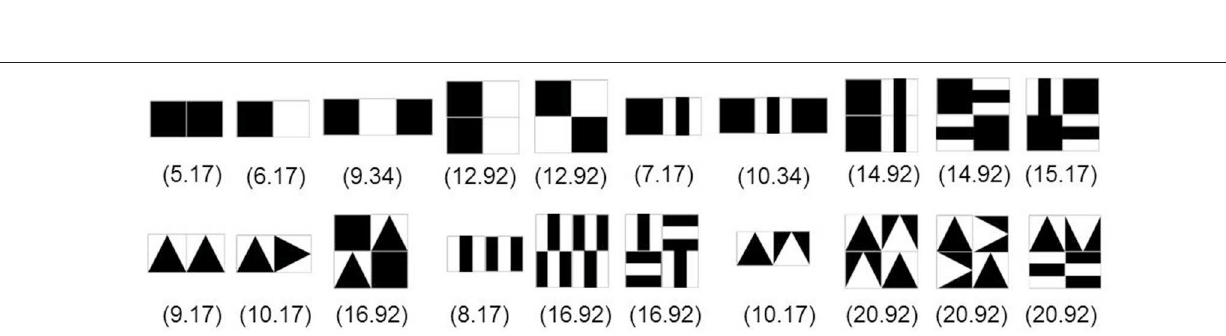
FIGURE 5 | Twenty TAG-Game A -GS items and calculated C play A values.